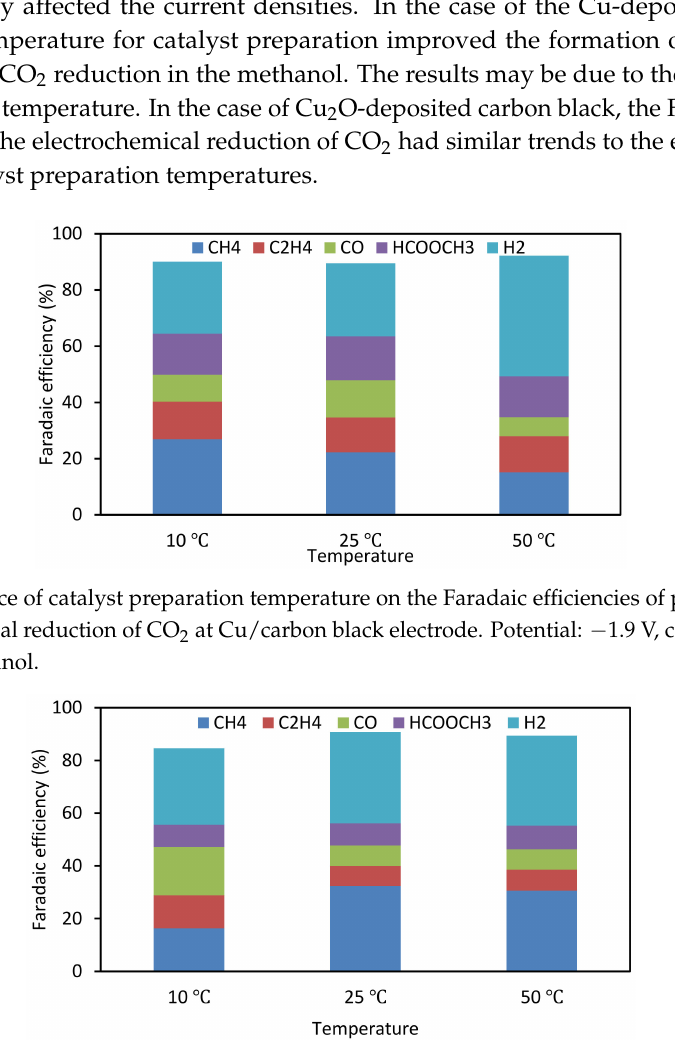
Figure 9. Influence of catalyst preparation temperature on the Faradaic efficiencies of products during the electrochemical reduction of CO 2 at Cu 2 O/carbon black electrode. Potential: − 1.9 V, catholyte: 0.15 M of NaCl in